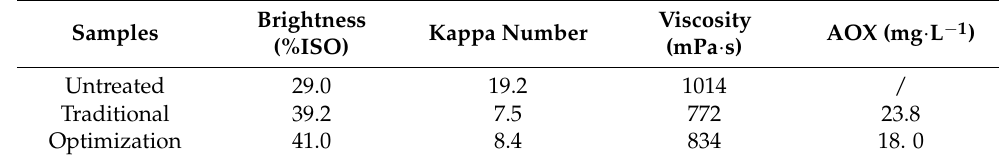
Table 2. Different pulp properties and AOX contents in bleaching wastewater.